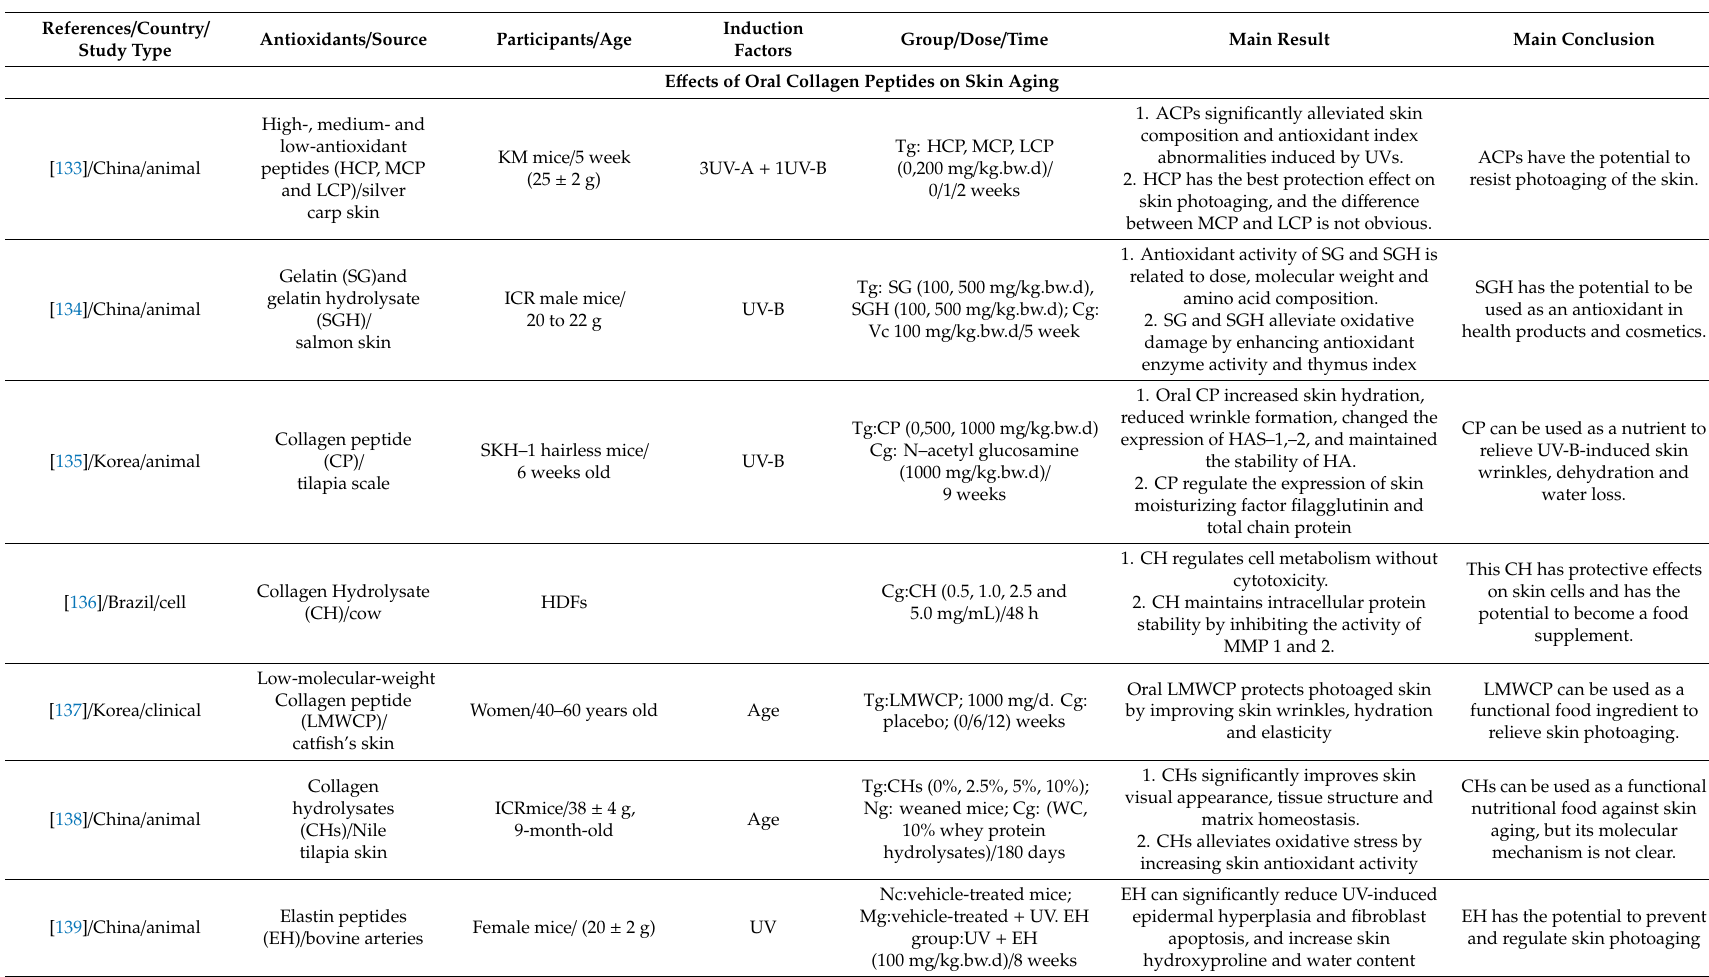
Table 2. Summary of the key in vivo studies investigating the potential e ff ects of foodborne antioxidants in the skin